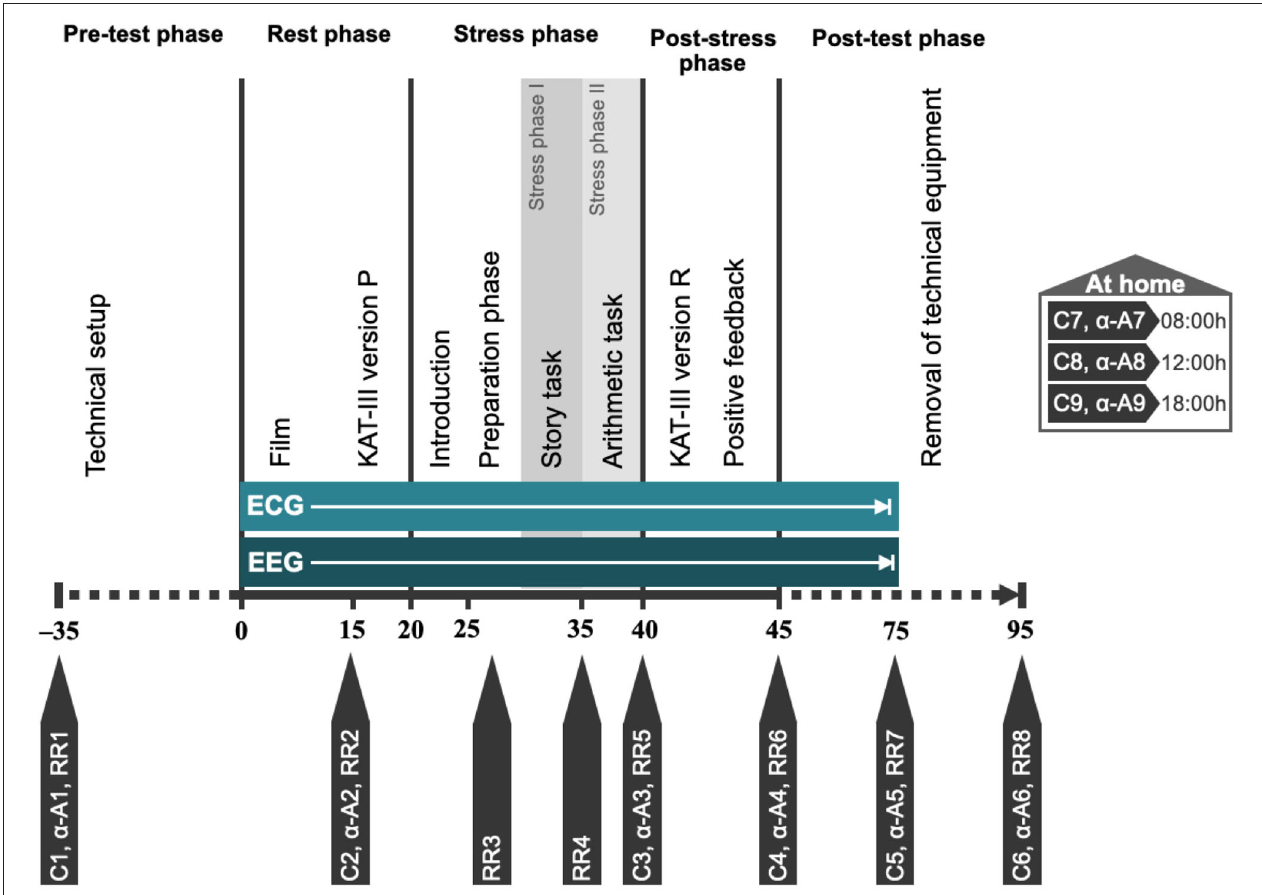
FIGURE 2 | Schematic representation of TSST-C procedure. C1–C9, saliva swabs 1–9 (cortisol); α -A1– α -A9, saliva swabs 1–9 (alpha-amylase); RR1–RR8, blood pressure measurements 1–8; KAT-III, German anxiety scale for children (Kinder-Angst-Test-III) – versions P (prospective) and R (retrospective).